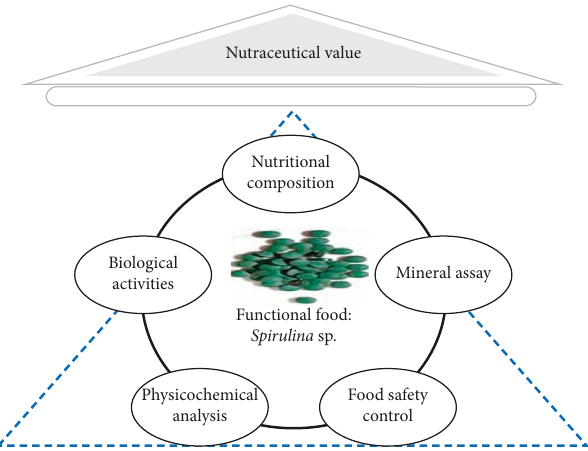
Figure 1: Crosstalk between nutritional and physicochemical properties and bioactivities in the functional food Spirulina species.